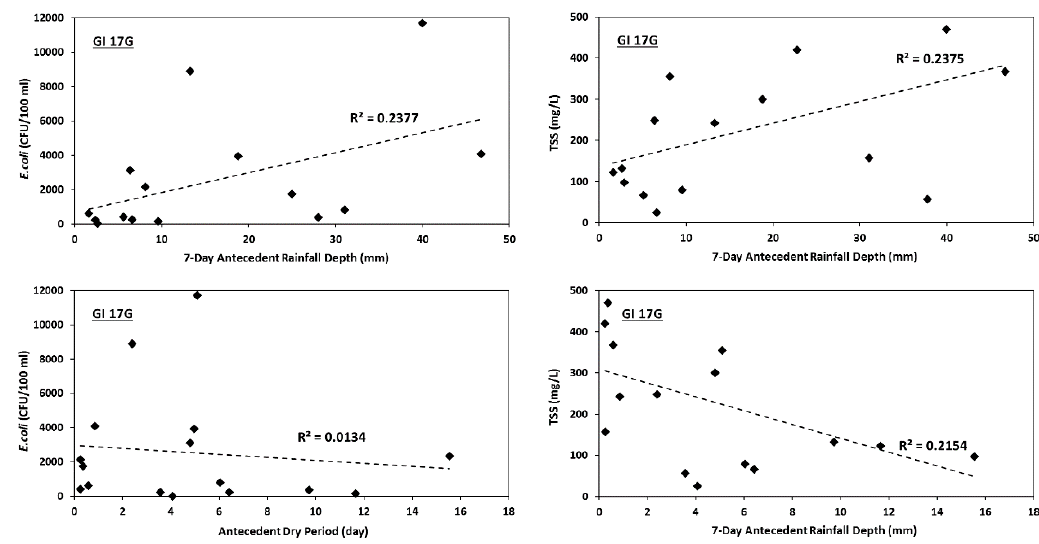
Figure 10. Runoff concentrations of E. coli and TSS versus antecedent rainfall conditions in GI 17G.